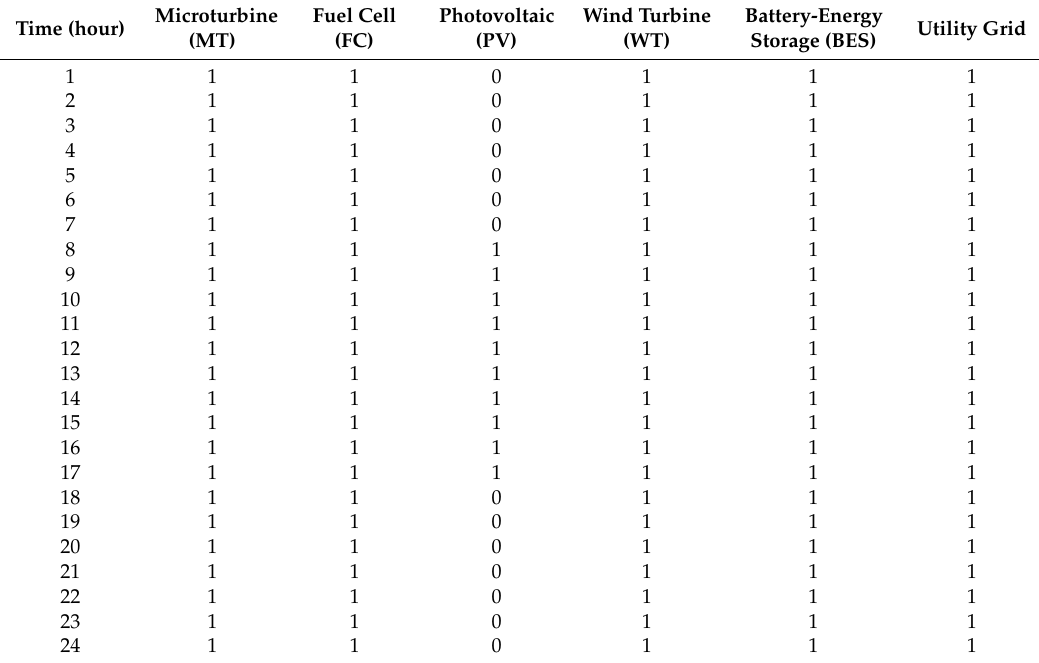
Table 3. Corresponding status of the generation sources obtained by GWO for Scenario B.